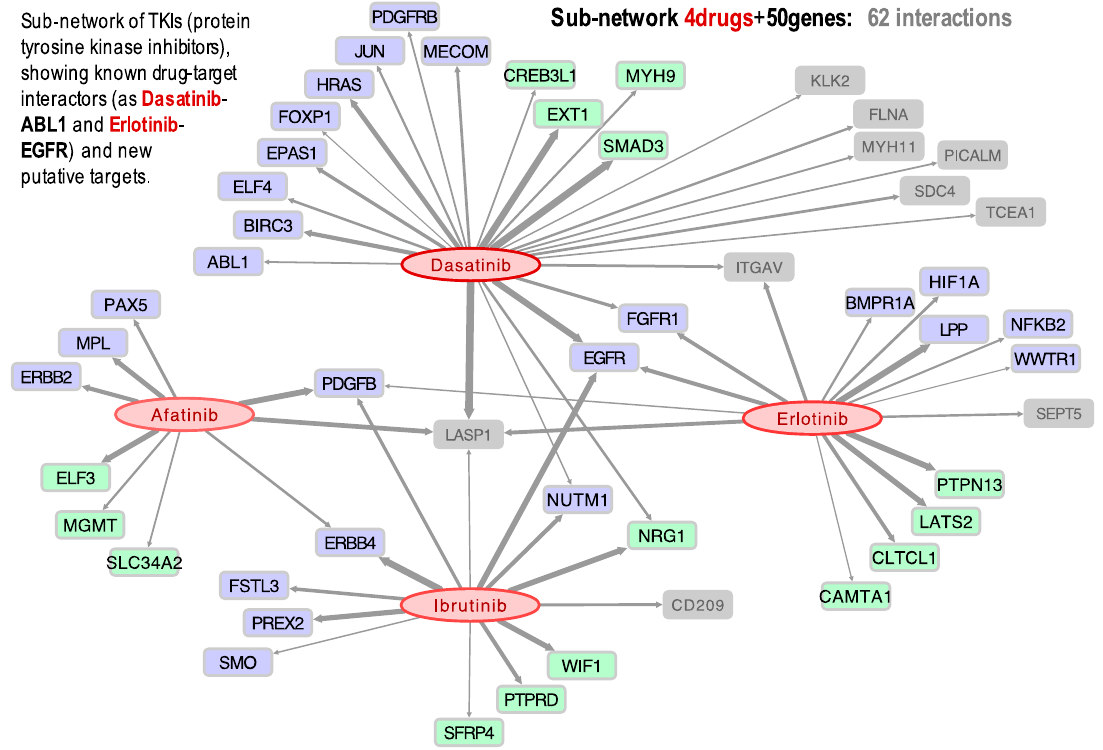
Figure 3. Bipartite directed sub-network of four drugs: Afatinib, Dasatinib, Erlotinib, and Ibrutinib, and their target cancer genes: 25 oncogenes (blue); 15 tumor-suppressors (green); and 10 other cancer-related genes (grey). The links (grey arrows) show the significant correlation found between the expression profiles of the genes and the activity of the drugs.